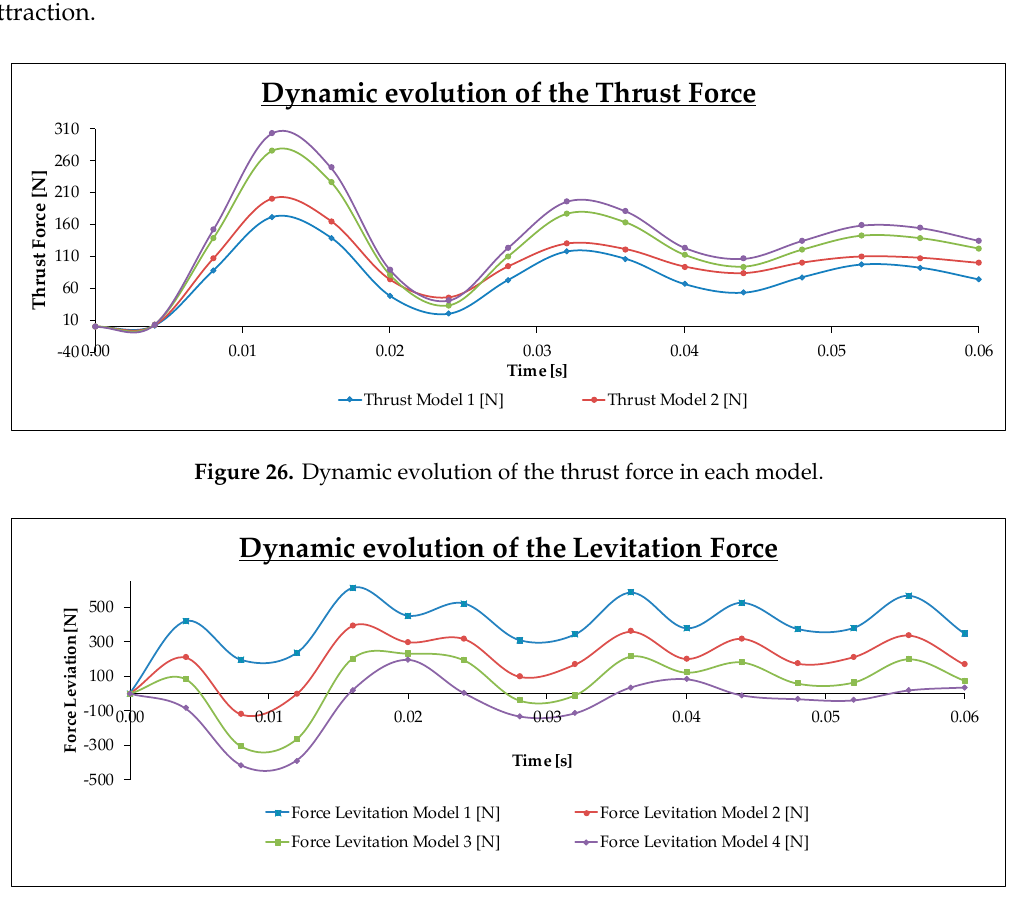
Figure 25. Levitation forces versus increment of transversal slots.